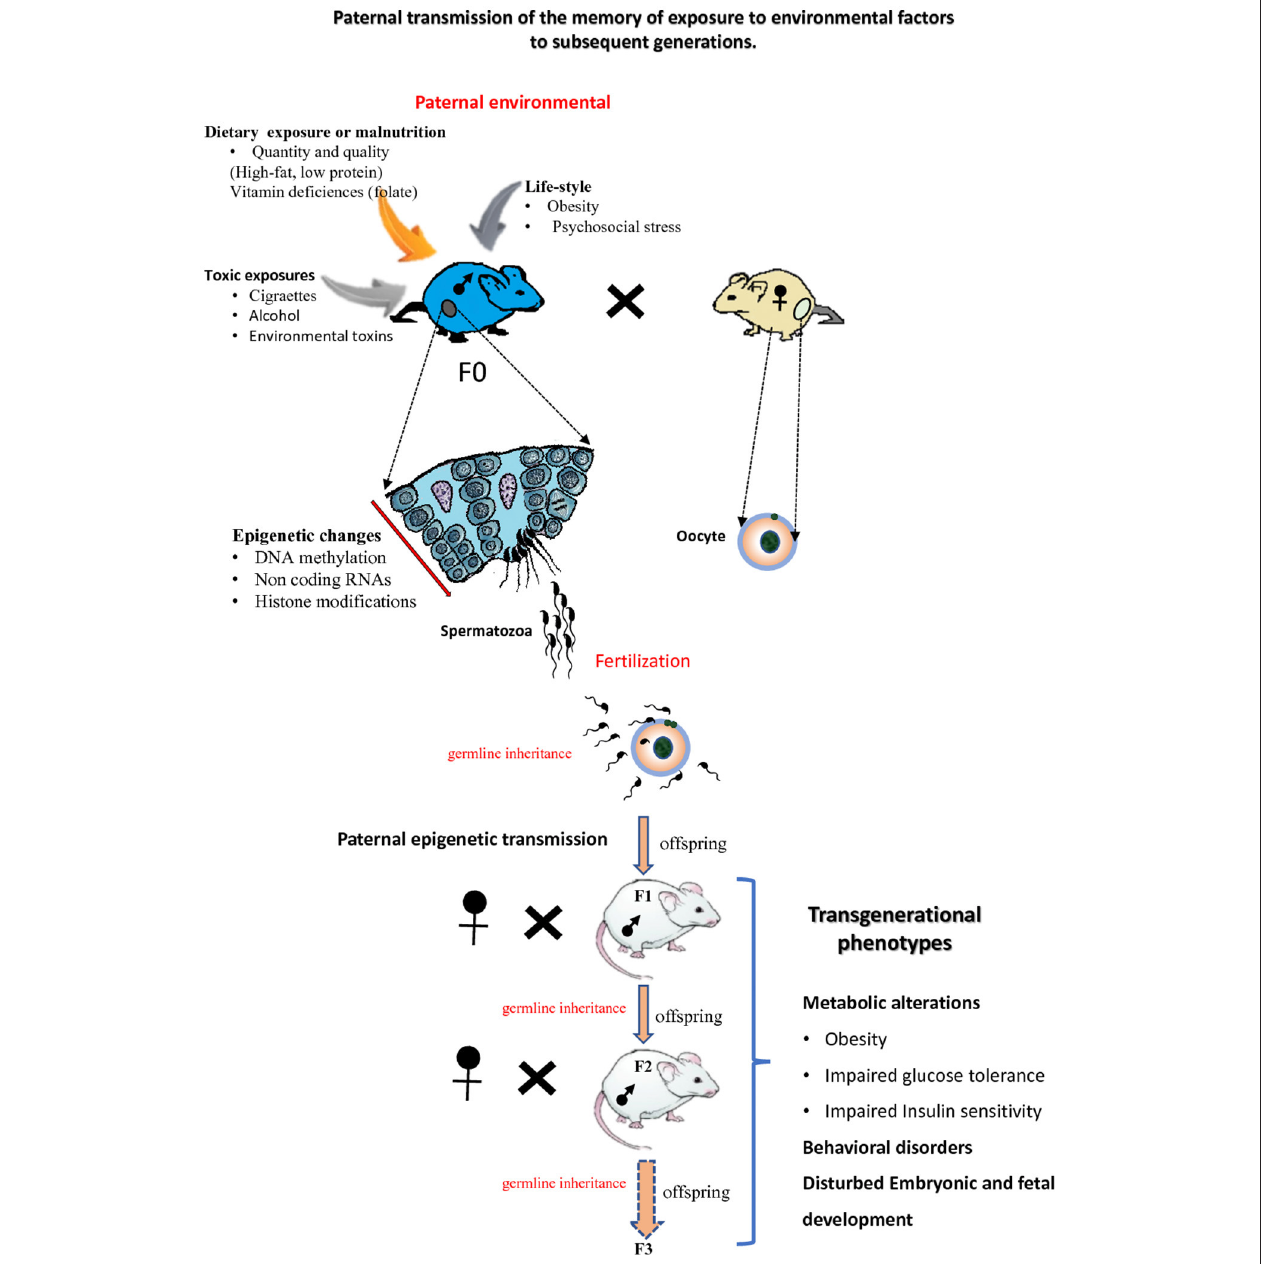
FIGURE 3 | Paternal epigenetic transmission to subsequent generations. Environmental exposures of male mice (F0) can modify the sperm epigenome. Epigenetic information about these exposures can be transmitted to the next F1 generation and also to the F2 generation or more F3. The offspring of subsequent generations can be subject to transgenerational